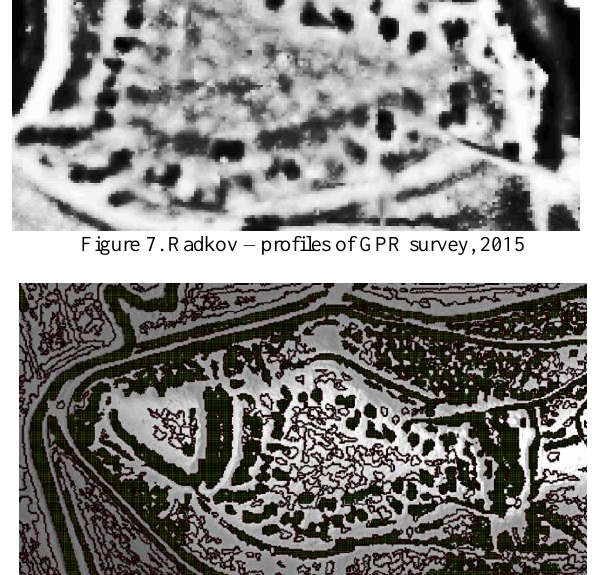
Figure 8. Radkov – point interpretations of the terrain relics of the archaeological